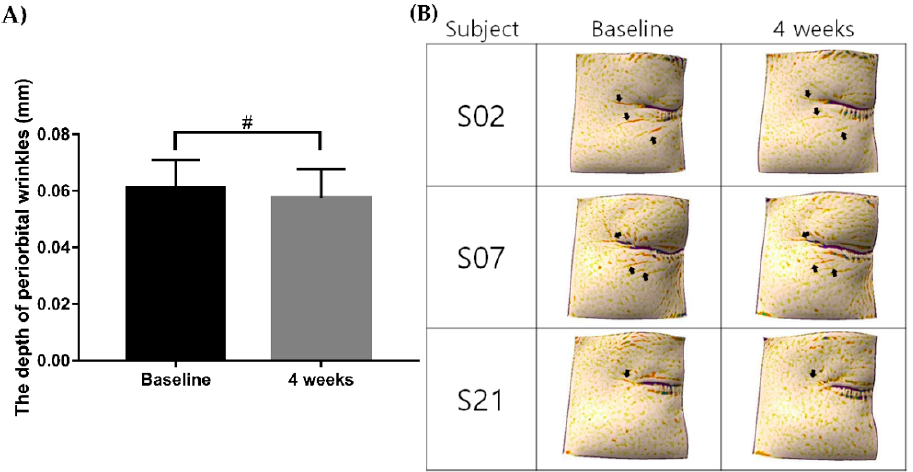
Figure 2. Comparison of the depth of periorbital wrinkles before and after 4 weeks of applying the CTP ampoule. The depth of periorbital wrinkles was reduced in response to application of the CTP ampoule over 4 weeks ( A ); # p < 0.001, Wilcoxon signed-rank test). The 4 week follow-up images taken with the Antera 3D ® (Miravex, Dublin, Ireland) are shown in ( B ). CTP ampoule, Ever Collagen Corrector Collagen Tripeptide Ampoule.